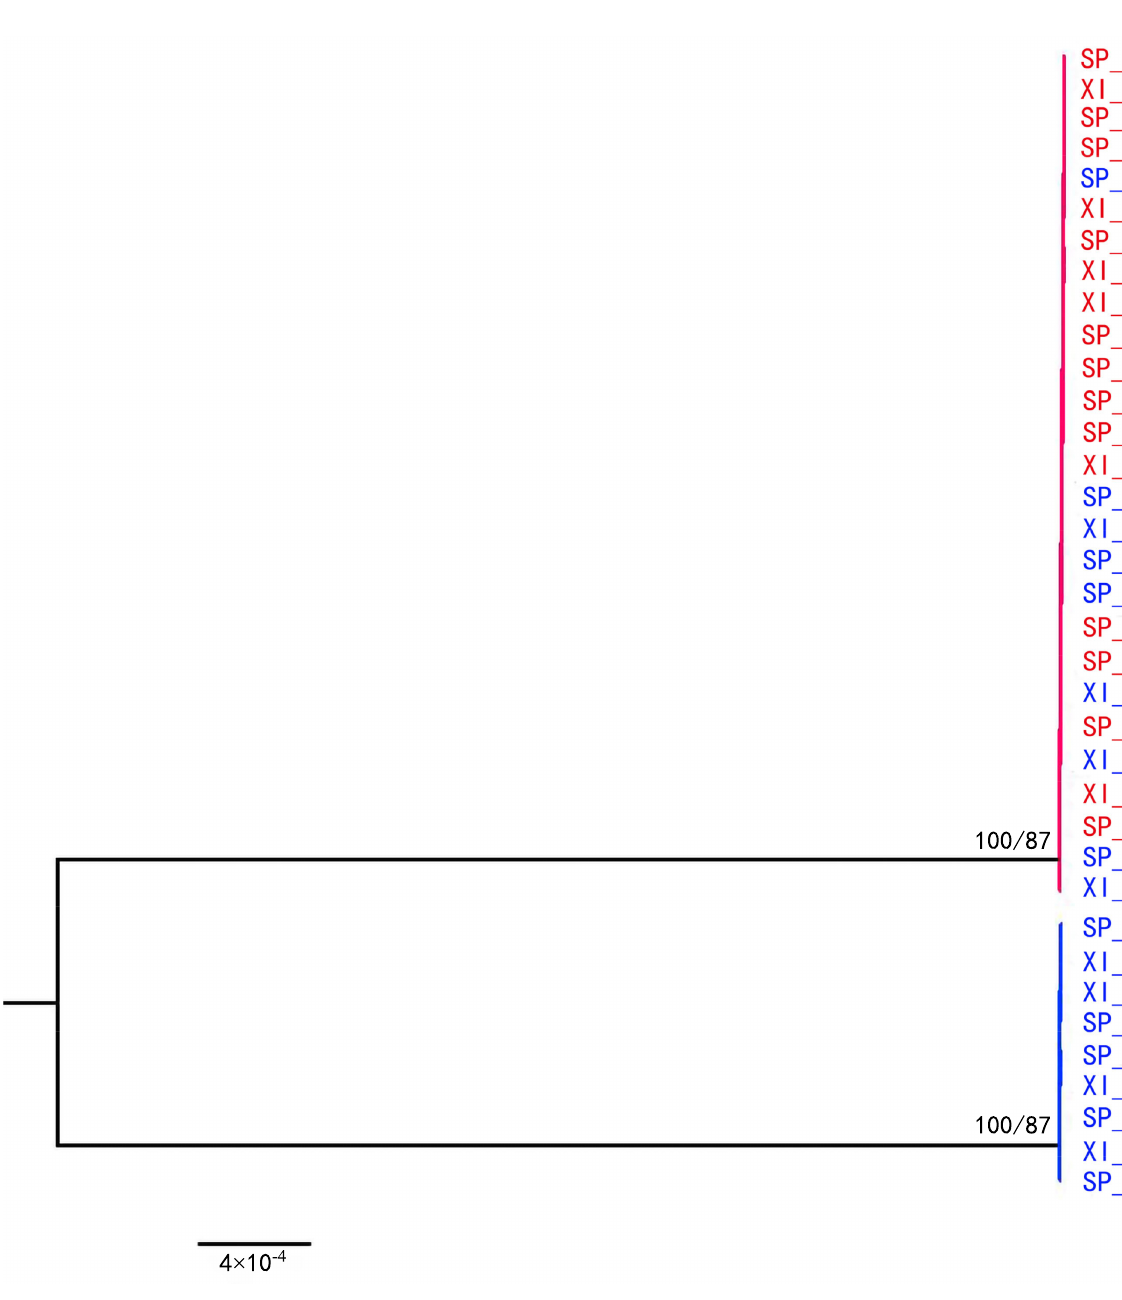
Figure 3. Gene genealogies for the shared XY site. Sequence label feature species (XI for A. xinduqio ; SP for A. sp.), sex (M for male; F for female), ID number, and allele (X, Y). Sequences from males are shown in blue, and those from females in red. The markers are on the ancestral sex-determining region of the sex chromosomes, and thus, are sex-linked in both species. Due to the absence of X–Y recombination, all sequences cluster by gametologs not by species. Bootstrap values are shown for the main branches (ML/NJ), when above